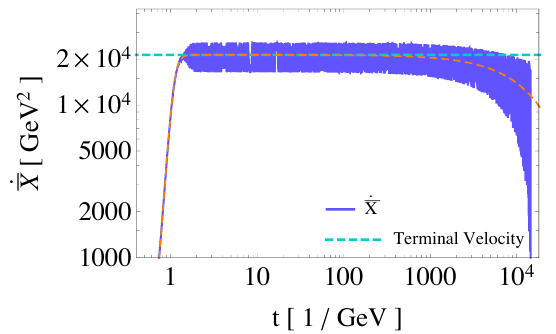
Figure 11 . The evolution of _ X during in(cid:13)ation with j (cid:8) j = 0 (blue line). Low scale in(cid:13)ation with the Hubble constant H = 10 GeV is assumed to take place after radiation domination. (The time variable t can be regarded as an e -folding number, N e = Ht .) During radiation domination, the strong dynamics responsible for the relaxion potential in eq. (9.1) does not exhibit con(cid:12)nement, and hence, the relaxion does not have any potential. The (cid:12)rst dynamics con(cid:12)nes at T ’ (cid:3) H , which generates the (cid:12)rst term in eq. (9.1), and the relaxion is accelerated. The second dynamics con(cid:12)nes at T ’ (cid:3) c , which modulate the relaxion potential. The dashed cyan line shows the terminal velocity expected for a purely linear potential. The dashed orange line shows the evolution of _ X without the second term in eq.